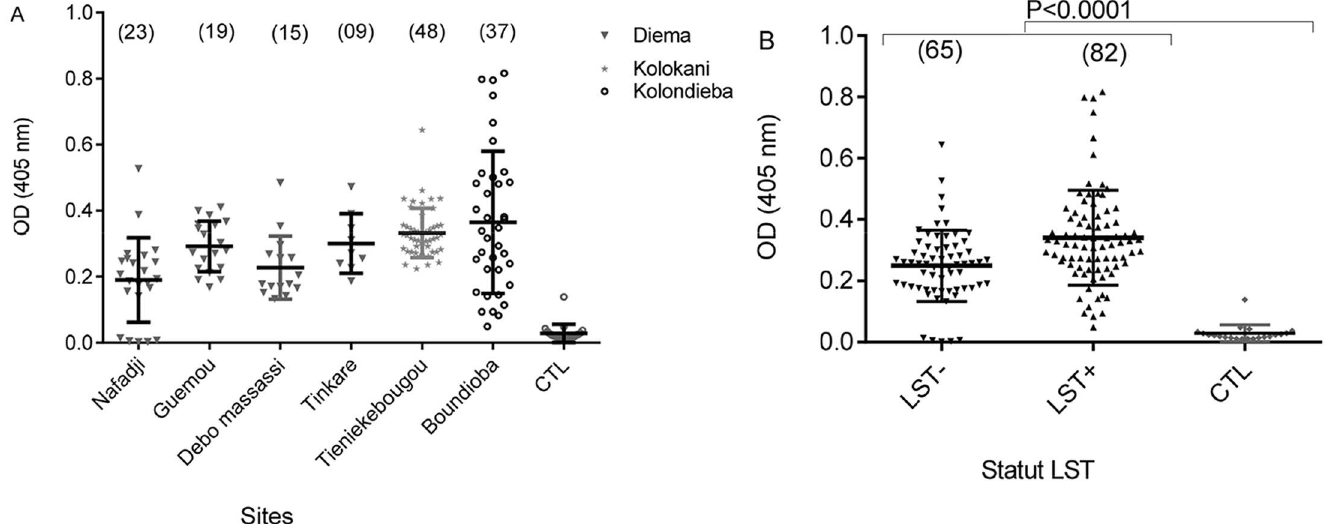
Fig 4. Optical density (OD) of antibodies against sand fly saliva measuredby ELISA. A) Antibodylevels in tested subjects from the 6 study villages. Samplesize is shown in brackets. B) Overall antibody levels in leishmanin positive (LST+) and negative(LST-) study subjects. CTL, non-endemiccontrols from US healthyvolunteersnot exposedto Leishmania .